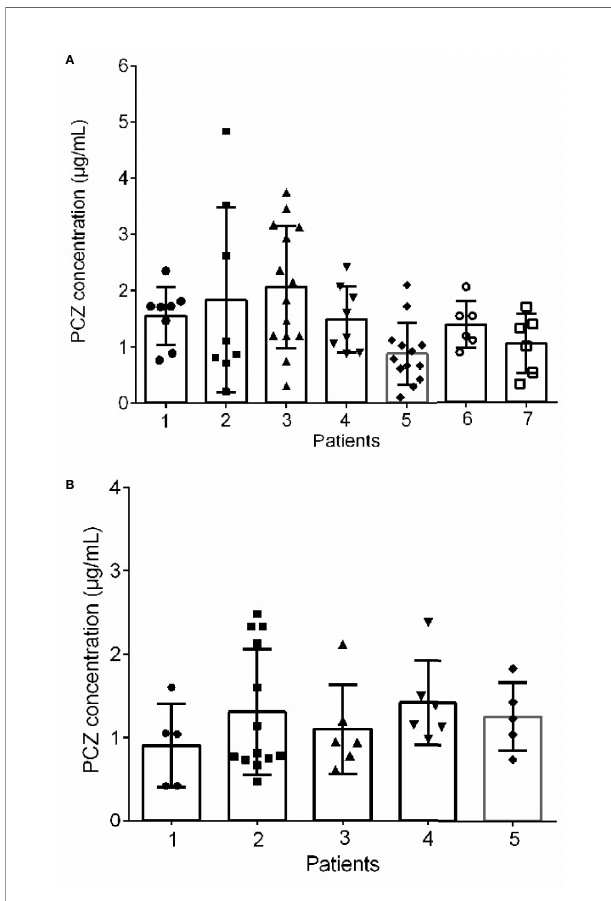
FIGURE 3 | Intra ‐ and inter-patient variability for patients received 800 mg/ day of PCZ suspension in prophylaxis (A) and treatment (B) groups. The graphs show mean values and SD